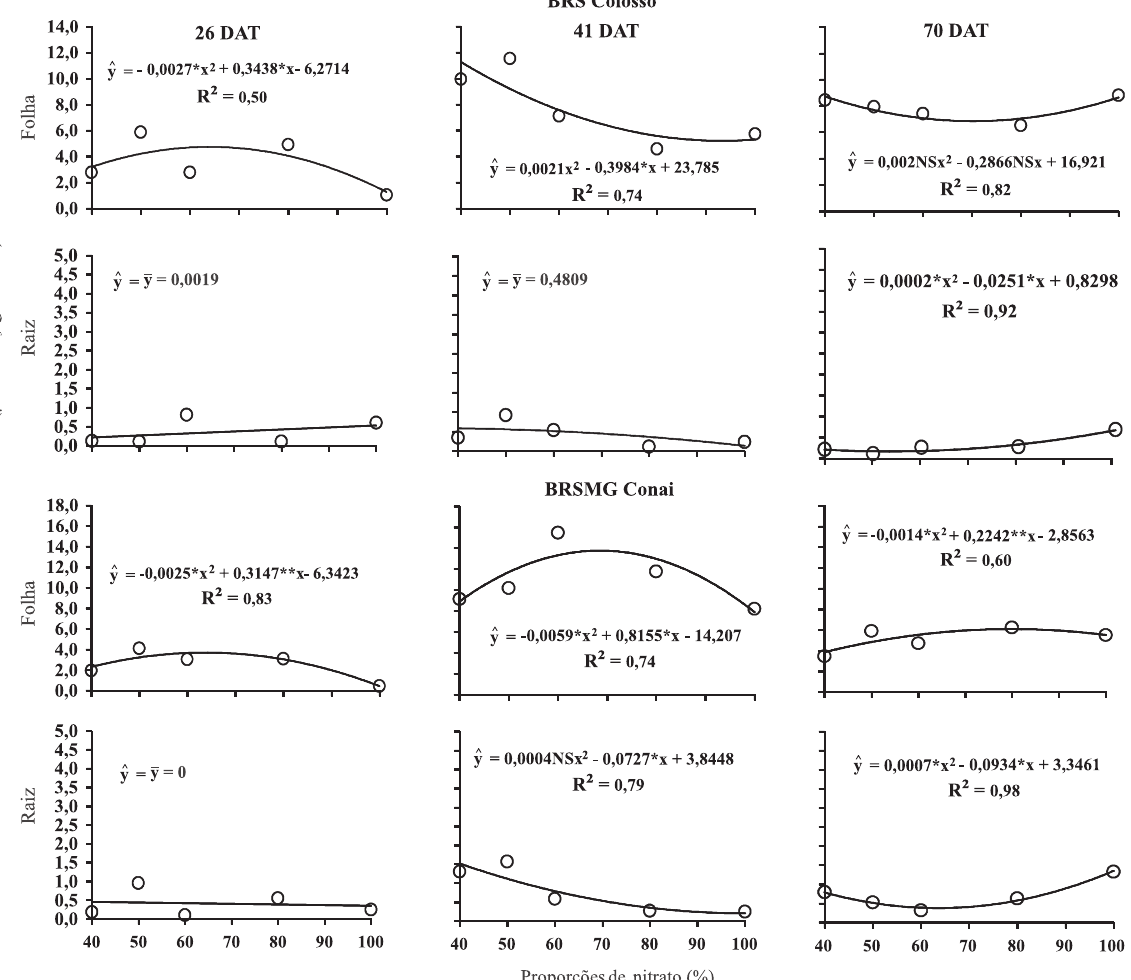
figura 3. Atividade da redutase do nitrato nas folhas e raízes das cultivares brs Colosso e brsmG Conai em função das relações nitrato:amônio e dos estádios de crescimento. dAt: dias após o transplantio. **, * e ns: significativo em níveis de p < 0,05 e p < 0,01,